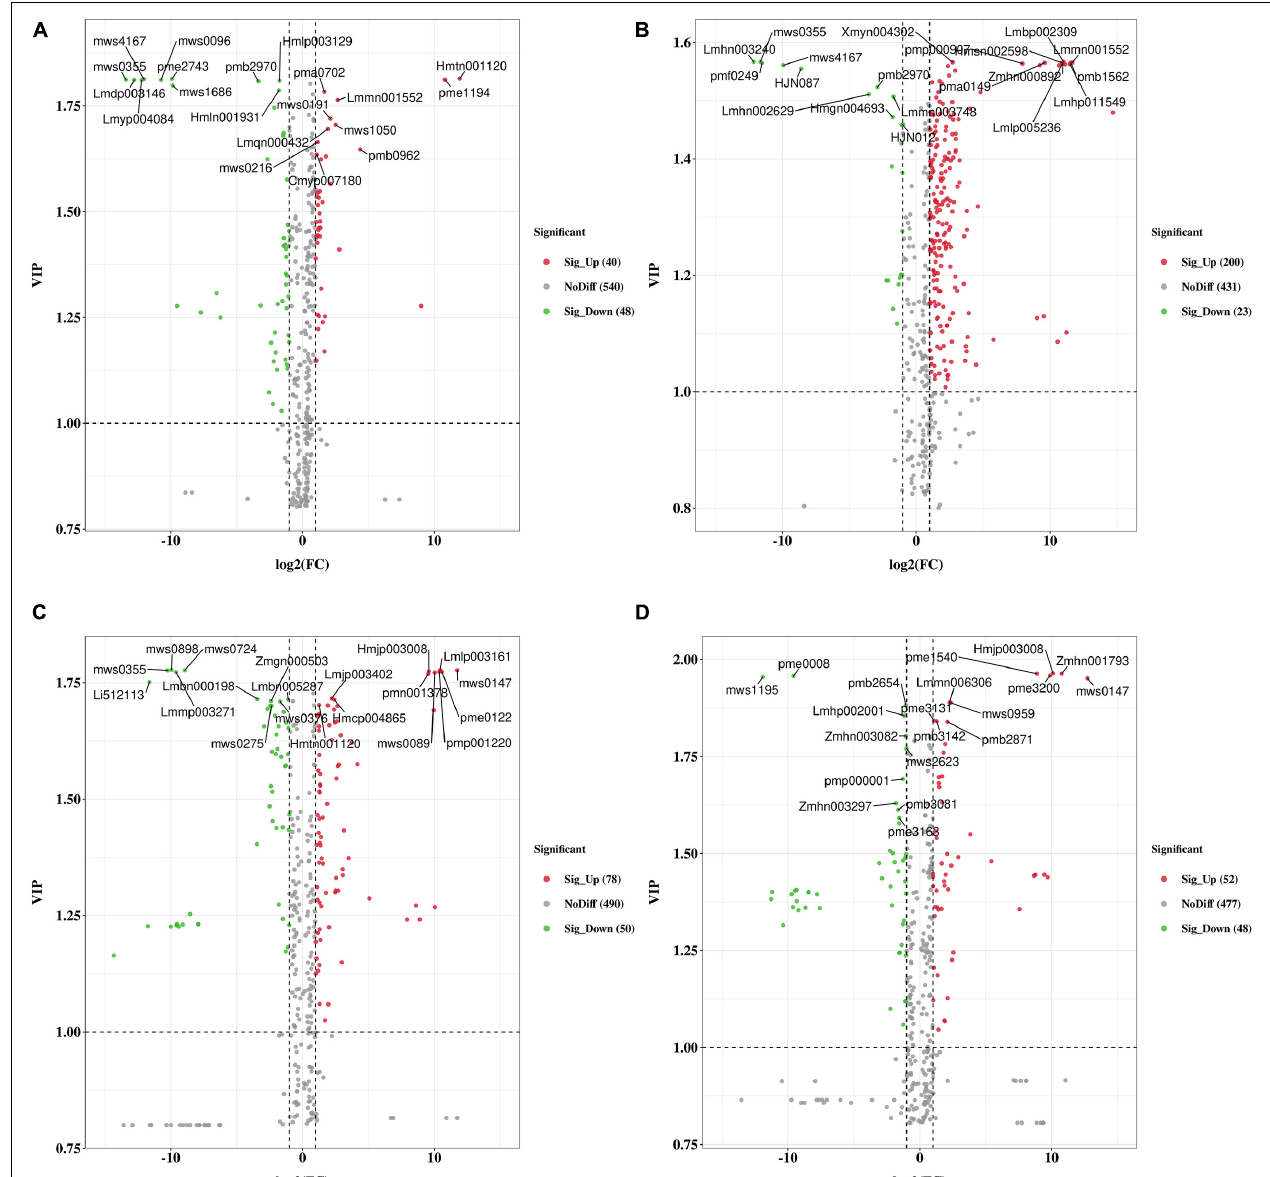
FIGURE 3 | The volcano plot of the differential metabolites in SW, TZ, OHW, and IHW in white-heart and red-heart Chinese fir. (A) Differences in group WH-SW vs. RH-SW. (B) Differences in group WH-TZ vs. RH-TZ. (C) Differences in group WH-OHW vs. RH-OHW. (D) Differences in group WH-IHW vs. RH-IHW. Green dots represent downregulated metabolites, red spots represent upregulated metabolites, and gray dots represent insignificant differences in metabolites. The top 10 VIP values were marked, respectively.